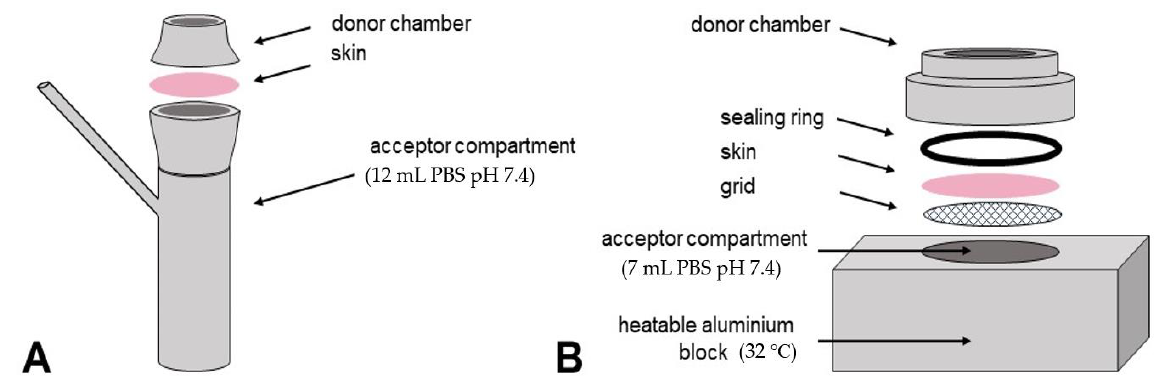
Figure 1. The schematic profiles of the off-line device ( A ) of Franz diffusion cell for skin incubation and in-line device ( B ) of skin incubation cells used.